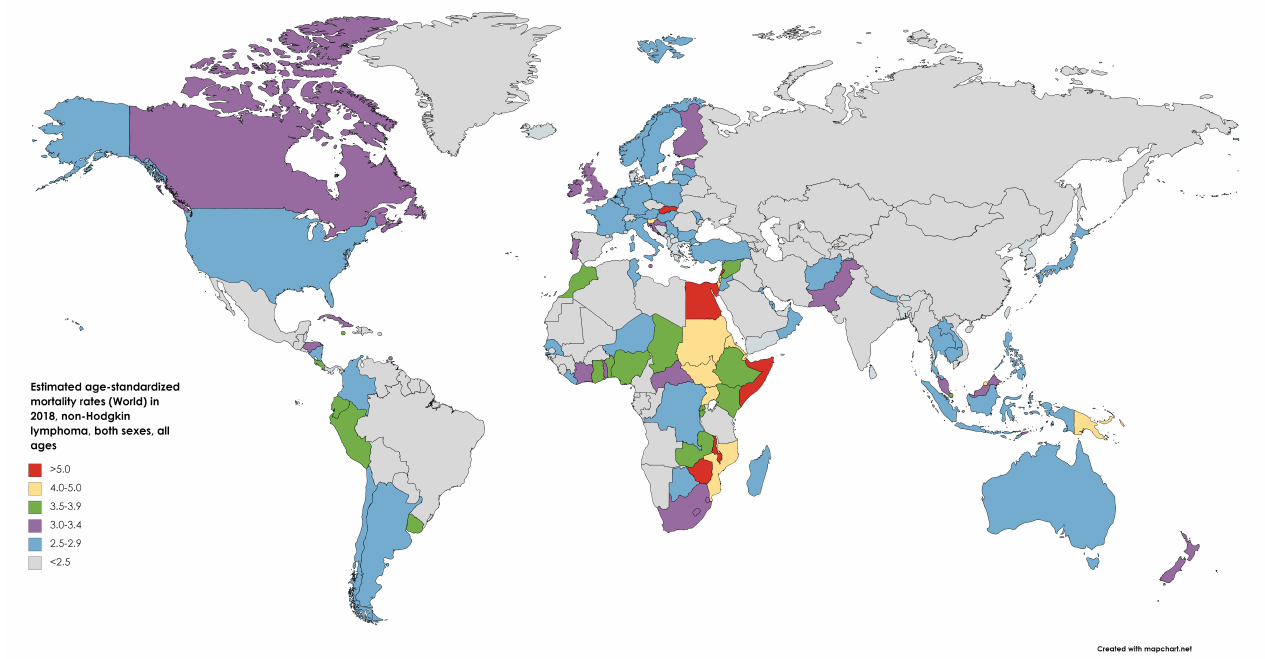
Figure 2. Map showing estimated age-standardized incidence rates (ASR) for non-Hodgkin’s lymphoma worldwide in 2018, all sexes, including all ages. Created with mapchart.net. Data obtained from Globocan 2018.